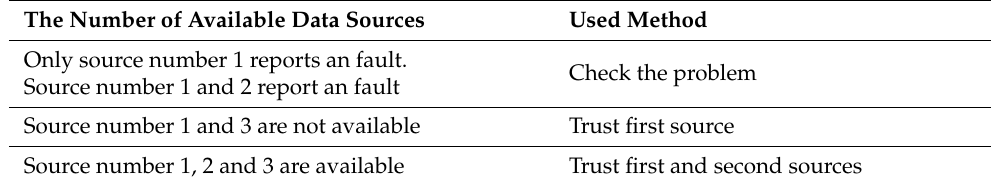
Table 9. Checking different situations in combining information according to available data sources. The Number of Available Data Sources Used Method Only source number 1 reports an